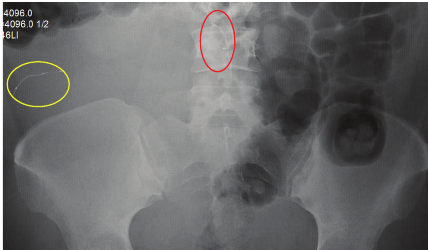
Figure 6: Patient Number 2, postpartum pelvic X-ray 10/13/15: Essure (circled in yellow) in the right upper quadrant around the liver. The 2nd Essure insert (circled in red) is seen by lumbar